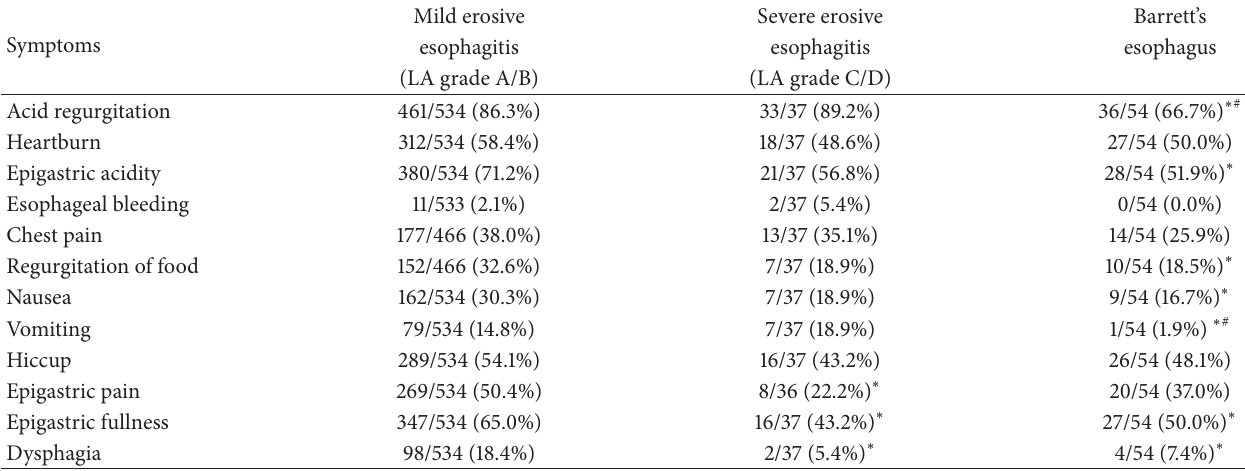
Table 2: Frequencies of gastroesophageal symptoms in patients with mild erosive esophagitis, severe erosive esophagitis, and Barrett’s